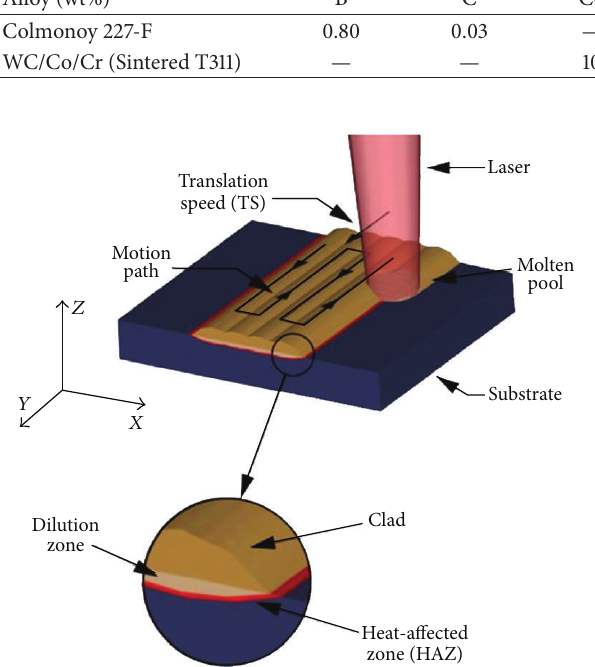
Figure 1: Schematic representation of the laser cladding process.